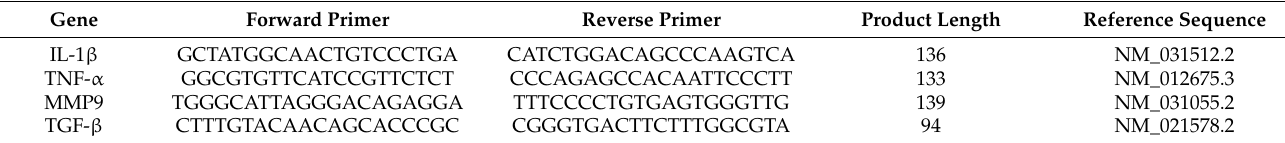
Table 3. Sequence of primers used in